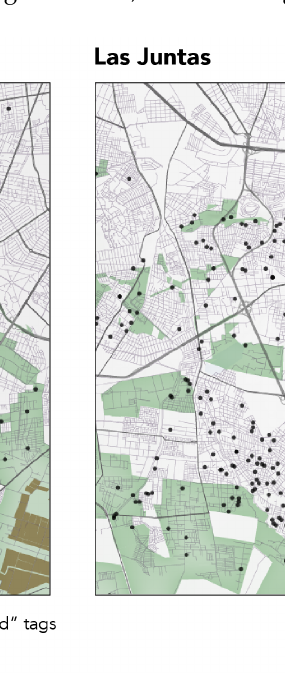
Figure 10. A tale of two